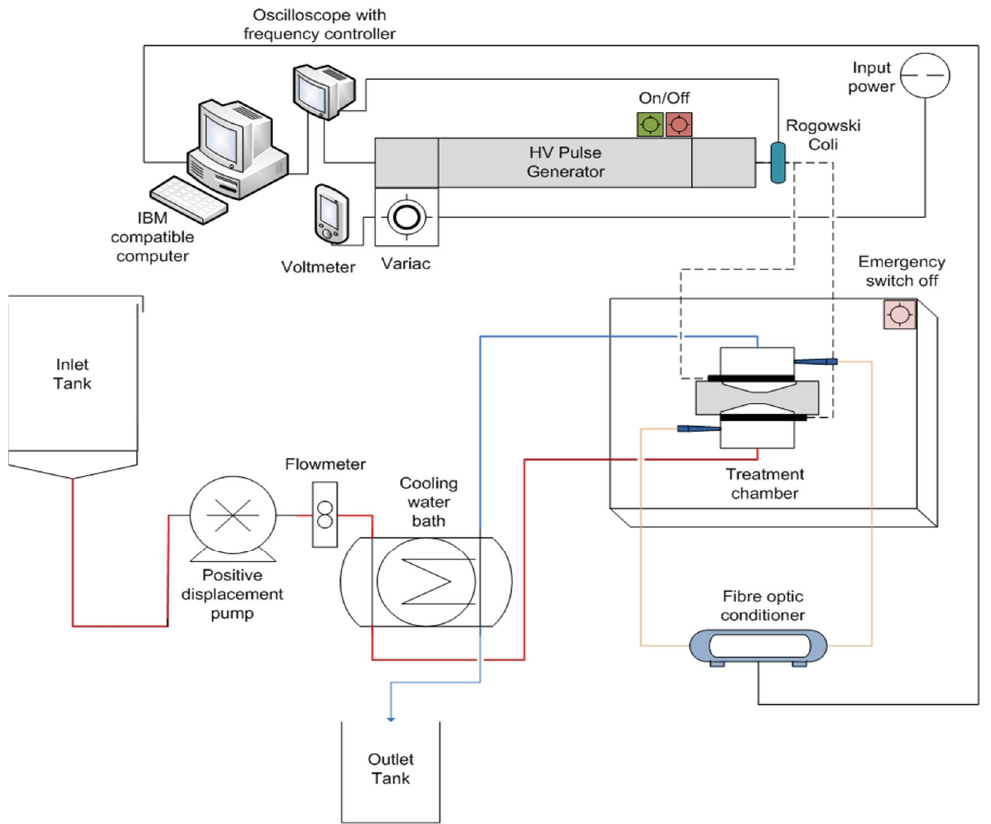
Figure 1. The pulsed electric field unit [24], located in the Chemical and Materials Engineering Department at the University of